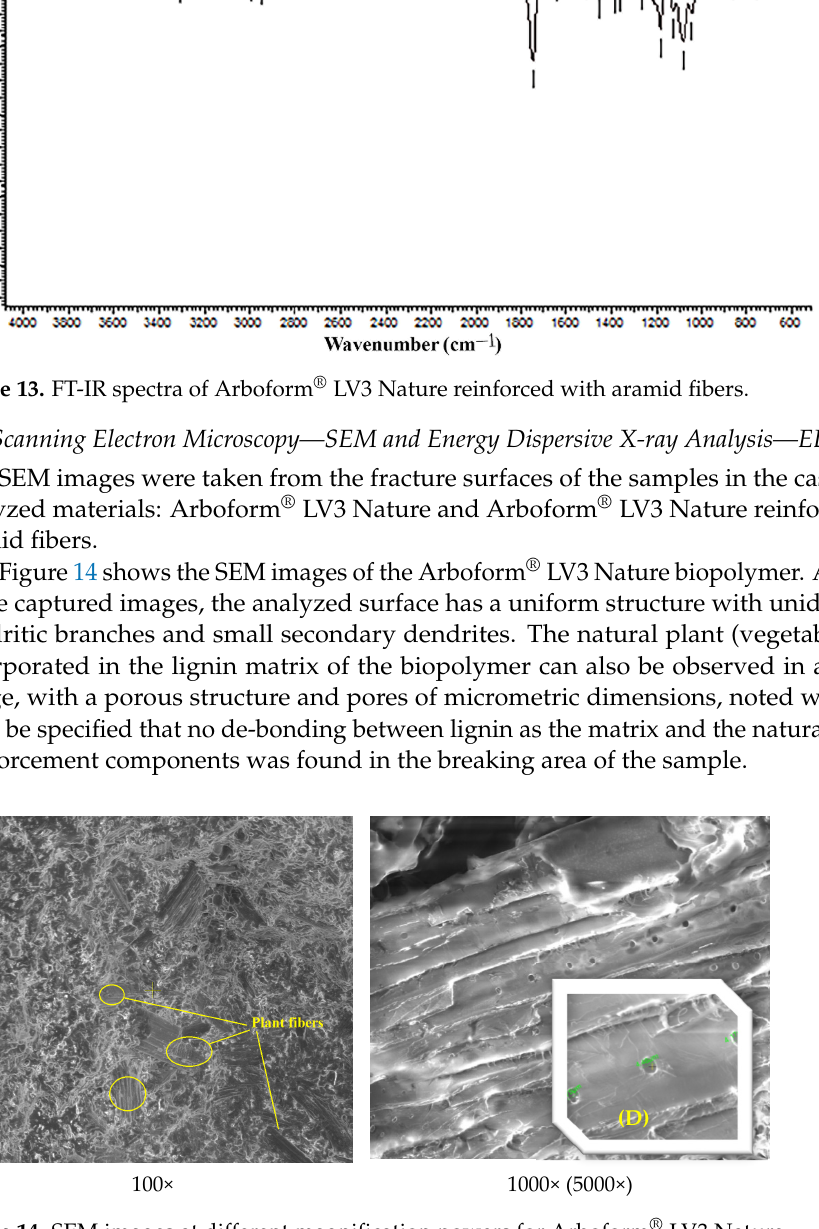
Figure 14. SEM images at different magnification powers for Arboform ® LV3 Nature. Figure 15 highlights the presence of aramid fiber imprints in the biopolymer matrix, with good dispersion and interfacial bonding.